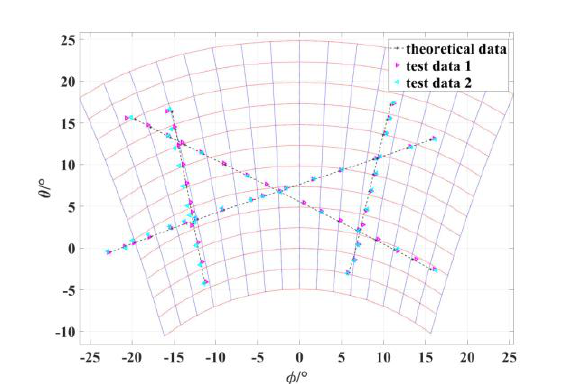
Fig. 9. Scanning map of EAST ECRH launcher on the projective target (distance L from the launching point is 2m)